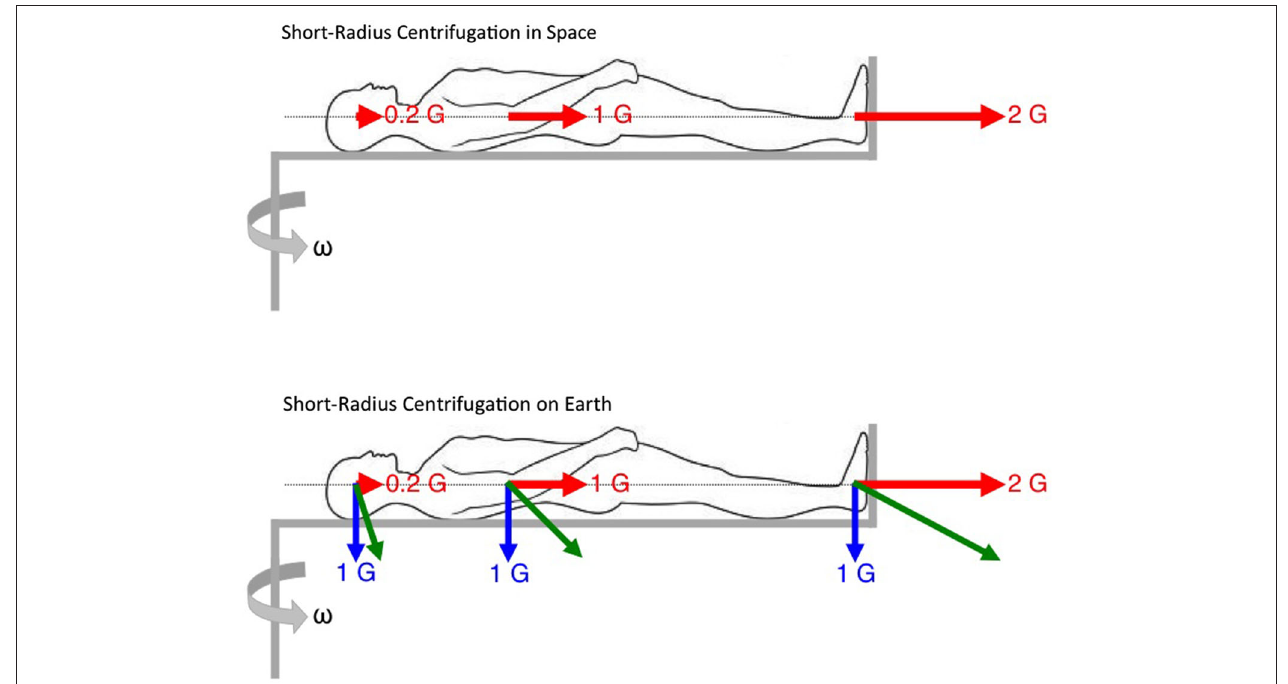
relative to vertical. In space, the centrifugal forces are the only forces generated by centrifugation and aligned with the longitudinal body axis. Note also the gravity gradient, i.e., the different magnitude of centrifugal force along the longitudinal body